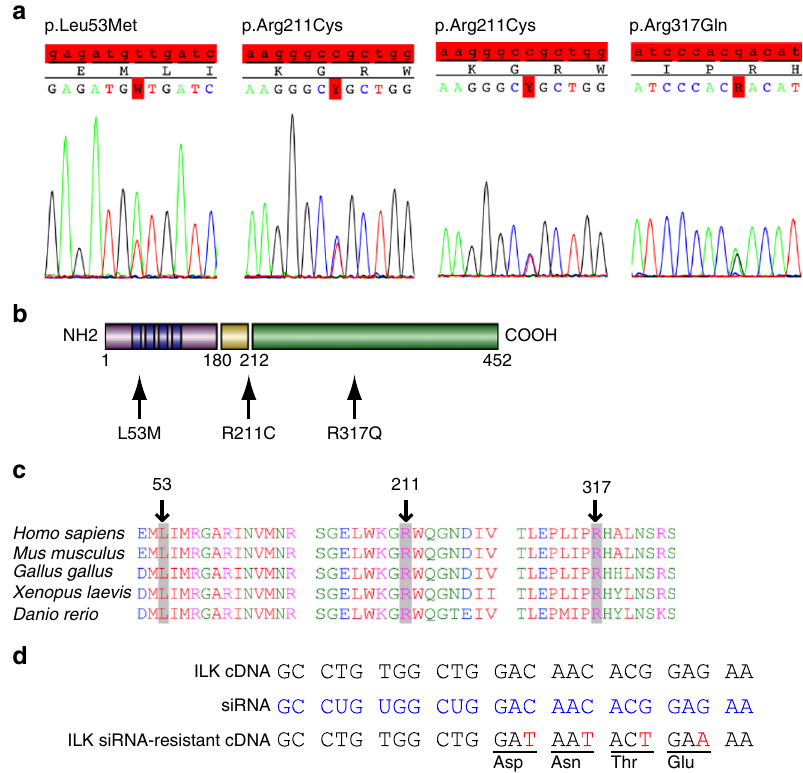
Fig. 6 ILK point mutations in human EVR patients. a , b Sanger sequencing of three different ILK point mutations identi fi ed in four patients ( a ). The corresponding changes in the primary sequence and location of the affected amino acid residues (red box) within different domains of the gene product are indicated ( b ). Mutation NM_004517.2:c.157T > A changes Leucine to Methionine at position 53 (p.Leu53M) of the ILK protein, NM_004517.2:c.631C > T changes Arginine to Cysteine at position 211 (p.Arg211Cys), and NM_004517.2:c.950G > A changes Arginine to Glutamine at position 317 (p.Arg317Gln). c Alignment of ILK amino acid sequences in different species, as indicated. Altered amino acid residues in FEVR patients are highlighted in gray and marked by arrows. All mutated sites are highly conserved. d ILK siRNA targeting strategy and generation of siRNA-resistant cDNA sequences, which avoid siRNA binding without changing the primary sequence of the gene